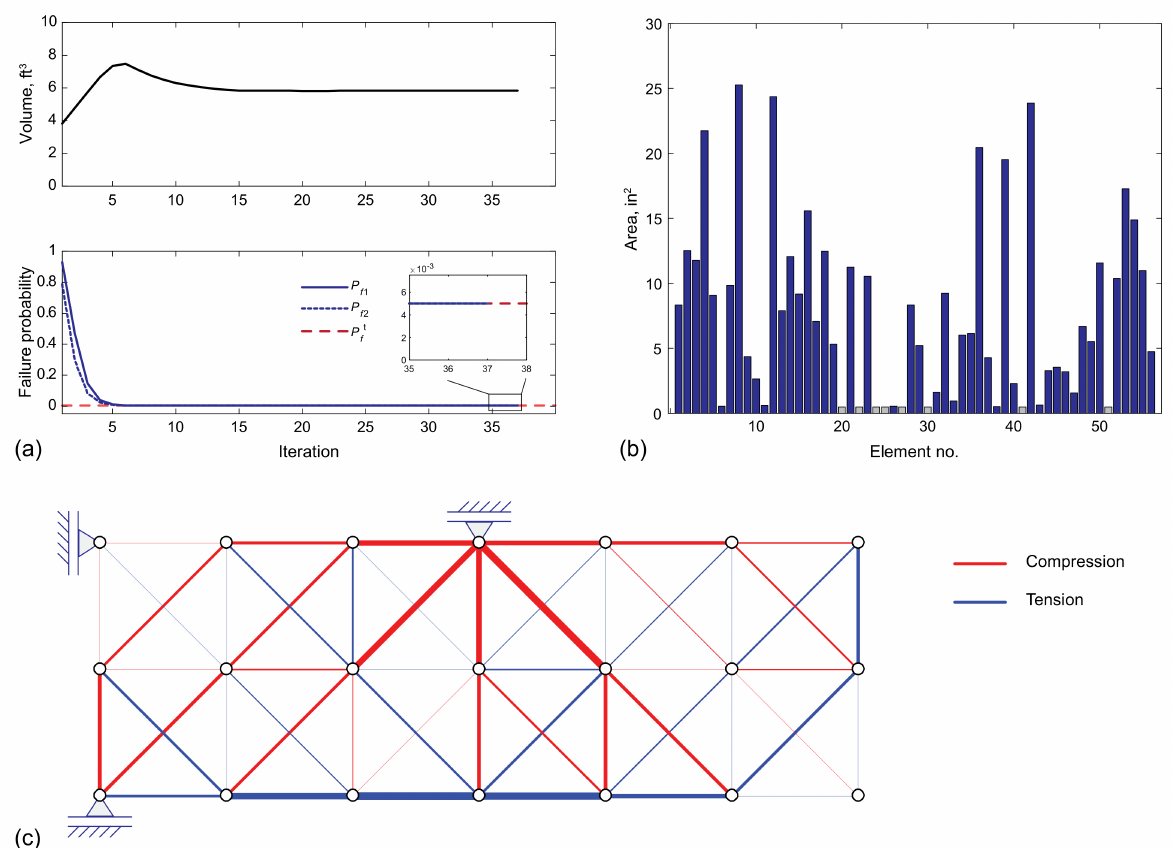
Figure 10. Results of the proposed RBDO − CS: ( a ) Convergence histories of volume and failure probability; ( b ) cross- sectional areas (elements having the minimum area of 0.5 in 2 are in grey); and ( c ) illustration of normalized cross-sectional areas of elements (elements in blue are in tension and those in red are in